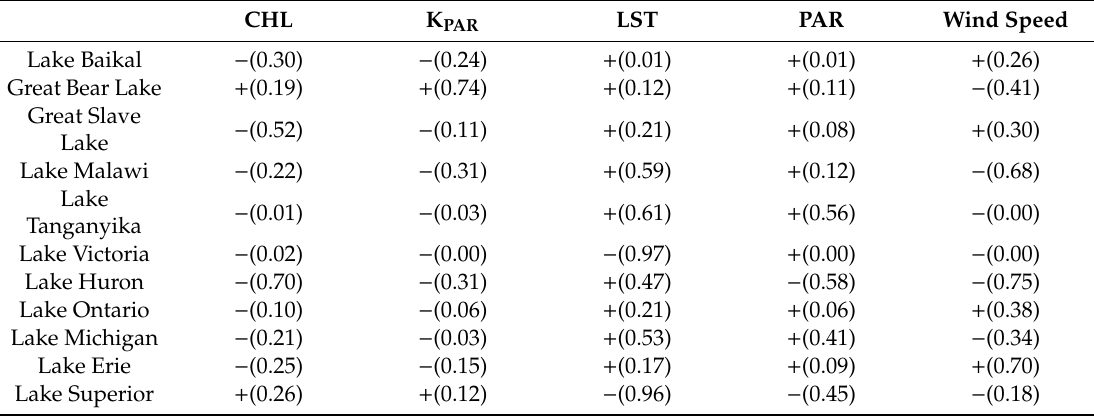
+ (0.26) + (0.12) − (0.96) − (0.45) −